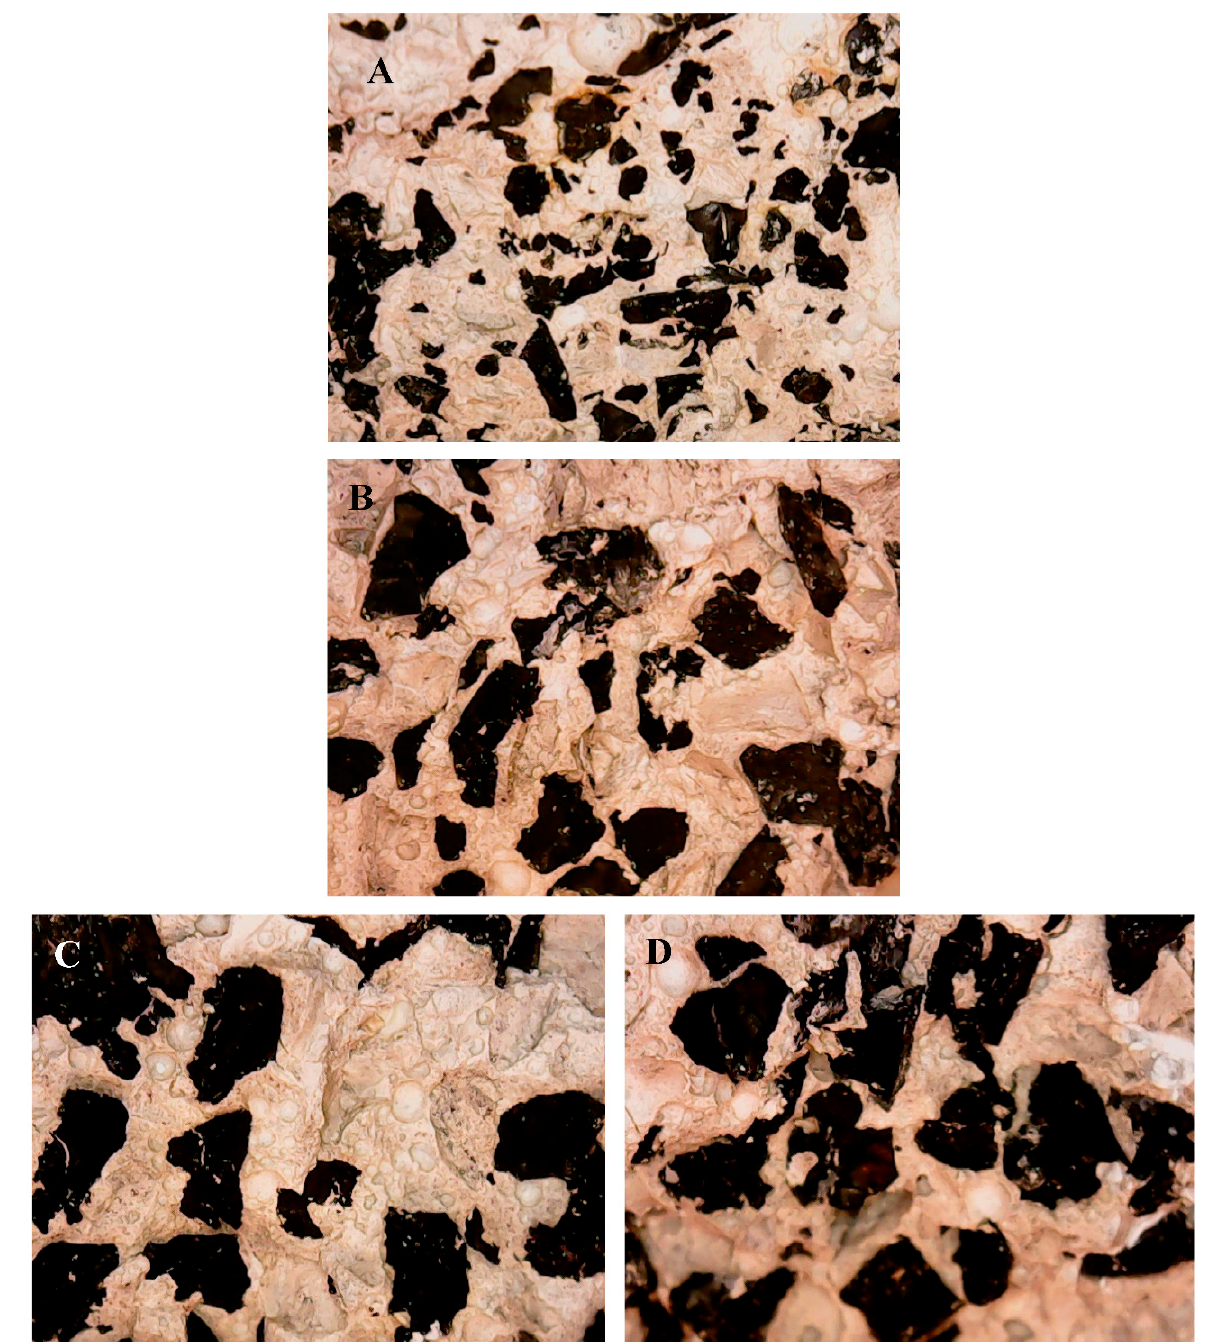
Figure 4. Sections of the ( A ) TR F (25%) sample (sample 1), ( B ) TR F /TR L (25%) sample (sample 3), ( C ) TR L (25%) sample (sample 2), ( D ) TR L (40%) sample (sample 8). The cross-section of these samples was analyzed by optical microscope after flexural rupture of the specimens.